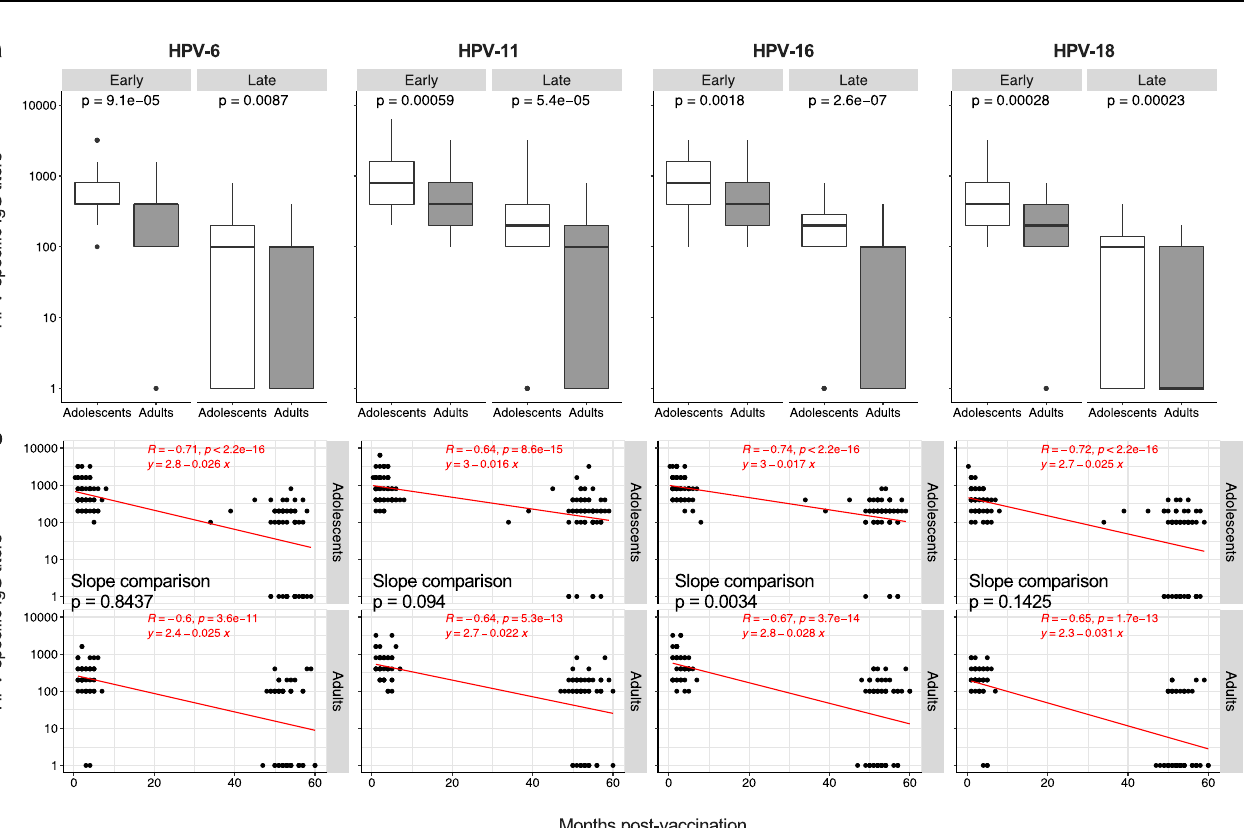
Fig. 1 Induction and maintenance of HPV-speci fi c IgG. a , b HPV-6, HPV-11, HPV-16, and HPV-18-speci fi c IgG titers measured by ELISA are shown as box and whisker plots ( a ) and correlated with time (months) post-vaccination ( b ); n = 60 and n = 59 for adolescents of the “ Early cohort ” and the “ Late cohort ” , respectively; n = 45 and n = 56 for adults of the “ Early cohort ” and the “ Late cohort ” , respectively. Statistical signi fi cance was determined by the Mann – Whitney ( a ) and Spearman ’ s rank correlation ( b ) and all p -values are shown. The box and whisker plots display the median (center line), the fi rst and third quartiles (the two hinges) and two whiskers: the upper whisker extends to the largest value no further than 1.5 × inter-quartile range (IQR) from the hinge while the lower whisker extends from the hinge to the smallest value at most 1.5 × IQR of the hinge. Data beyond the end of the whiskers are plotted individually. The equation of the regression lines has to be intended as: Log(y) = q + mx, and the comparison between slopes (adolescents vs adults) was calculated by ANCOVA ( b ). “ Early cohort ” , Early; “ Late cohort ” ,